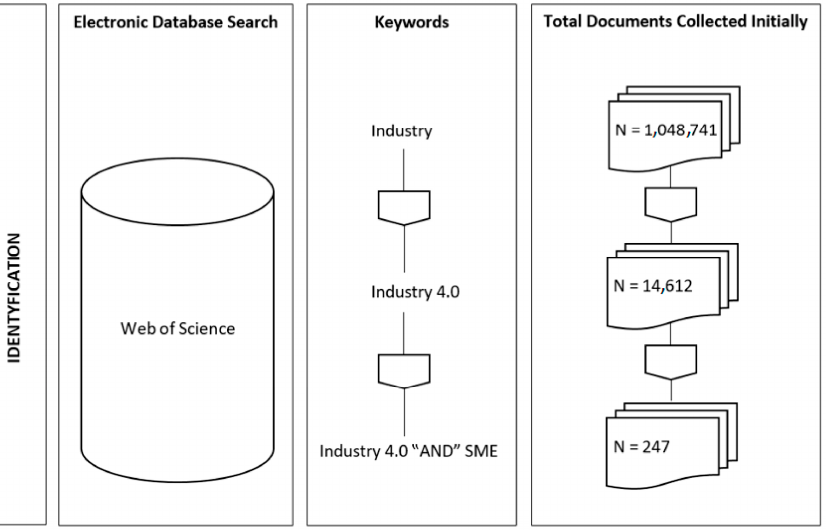
Figure 4. Identification stage of the PRISMA framework related to Industry 4.0 in the SME sector. Source: own study, based on the PRISMA methodology.